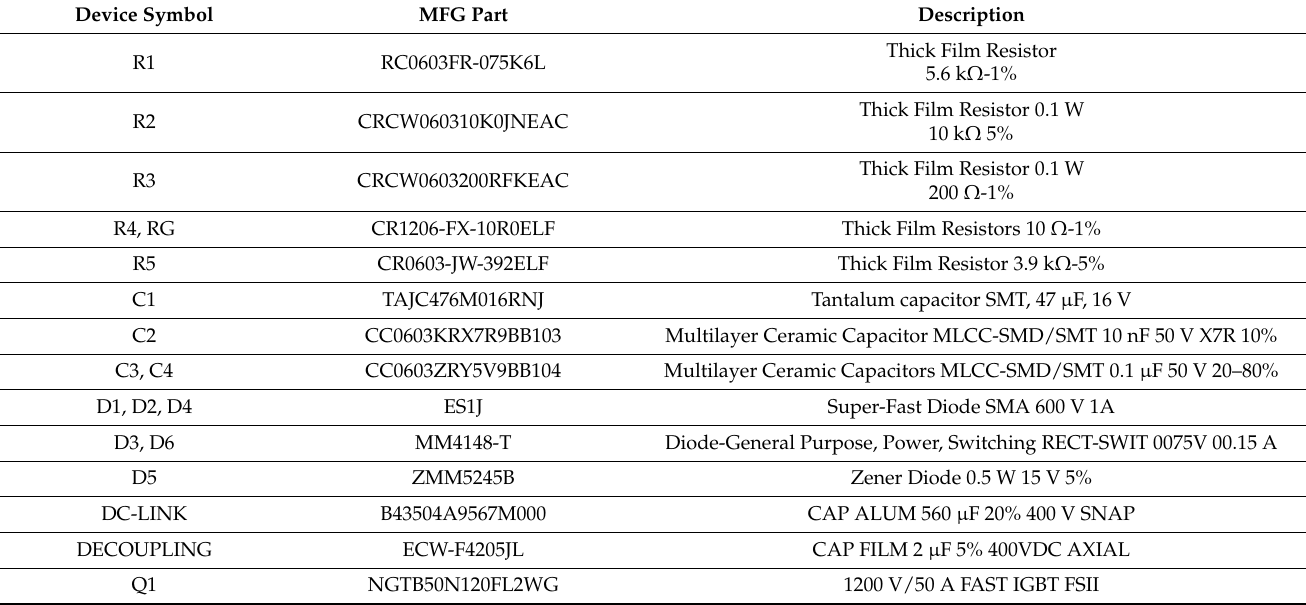
Table 2. Bill of material for the applied short-circuit current diagnostic